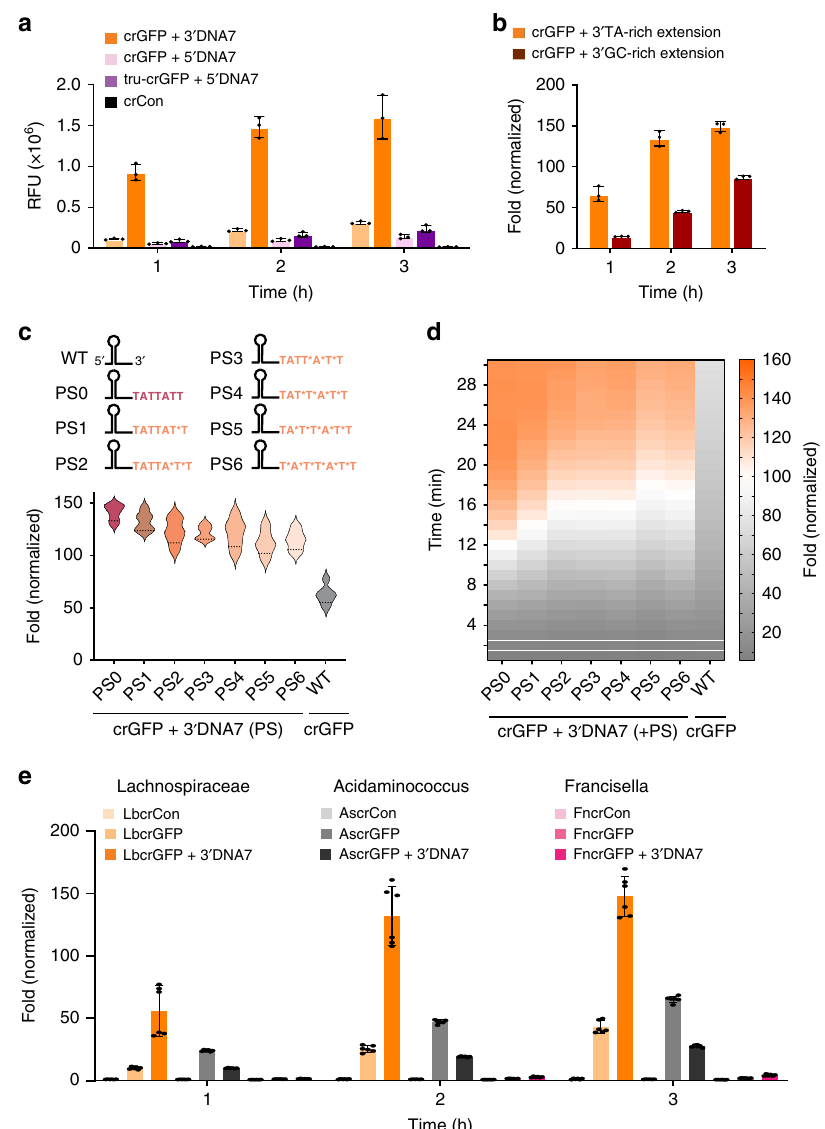
Fig. 3 Characterization of ENHANCE with various crRNA modi fi cations and different Cas12a systems. a Comparison of trans-cleavage activity between precursor crRNA (pre-crRNA) and mature crRNA (tru-crRNA, where the fi rst Uracil on the 5 ′ -end of the crRNA is cleaved by LbCas12a in the absence of the activator). b Comparison of trans-cleavage activity between AT-rich extensions and GC-rich 7-nt DNA 3 ′ -end extensions on the crRNA + 3 ′ DNA7. For a , b ), error bars denote mean ± SD, where n = 3 technical replicates. c Trans-cleavage activity of LbCas12a with non-fully phosphorothioate (PS) modi fi ed crRNA targeting GFP fragment. Sequence representation of 6 non-fully PS extension on the 3 ′ -end of crGFP ranging from 1 to 6 PS. The asterisk symbol (*) signi fi es the phosphorothioated nucleotide. The graph below the sequence representation shows fold change of the LbCas12a fl uorescence-based reporter assay with the activator normalized to the corresponding samples without the activator at t = 20 min. d kinetics of the LbCas12a fl uorescence-based reporter assay in c , e Trans-cleavage activity of different variants of Cas12a. The pre fi x Lb, As, and Fn stand for Lachnospiraceae bacterium, Acidaminococcus, and Francisella novicida, respectively. For c , d , and e , n = 6 replicates (three technical replicates examined over two independent experiments), where error bars in e represent mean ± SEM. Source data are available in the Source Data fi